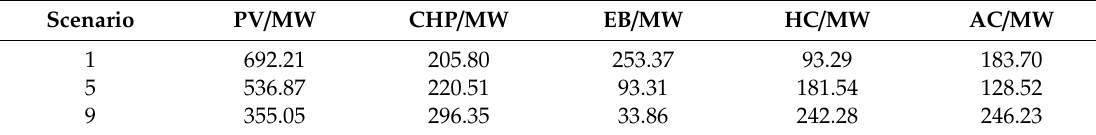
Table 5. Regrets under multiple natural gas price fluctuation scenarios. Values